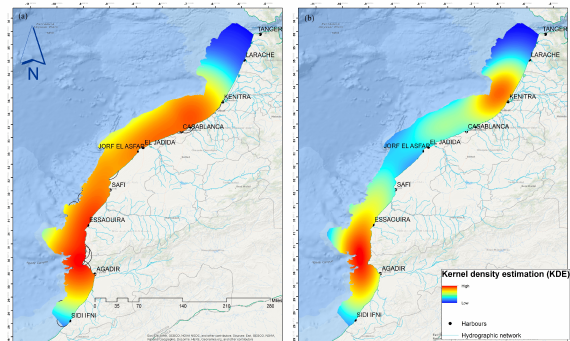
Figure 6. The prediction map of debris distribution using kernel density tool